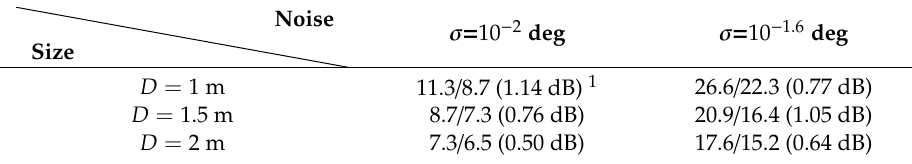
Table 1. Comparison of the positioned RMSEs of the wireless nodes.